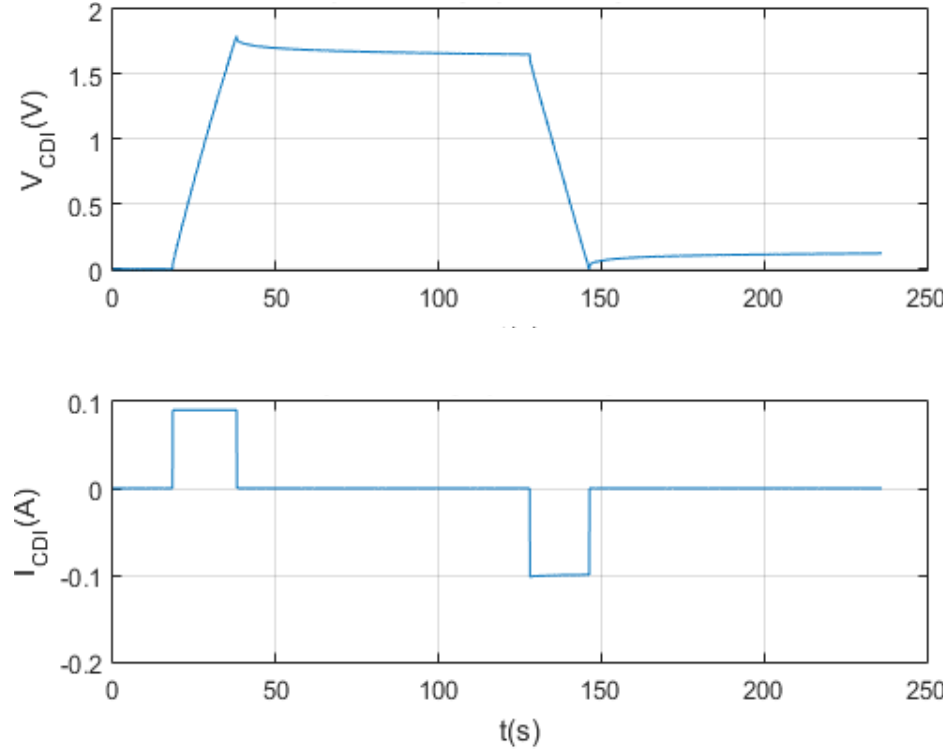
Figure 18. Charge and discharge test at Vcmax = 1.8 V and Icon = 0.1 A.